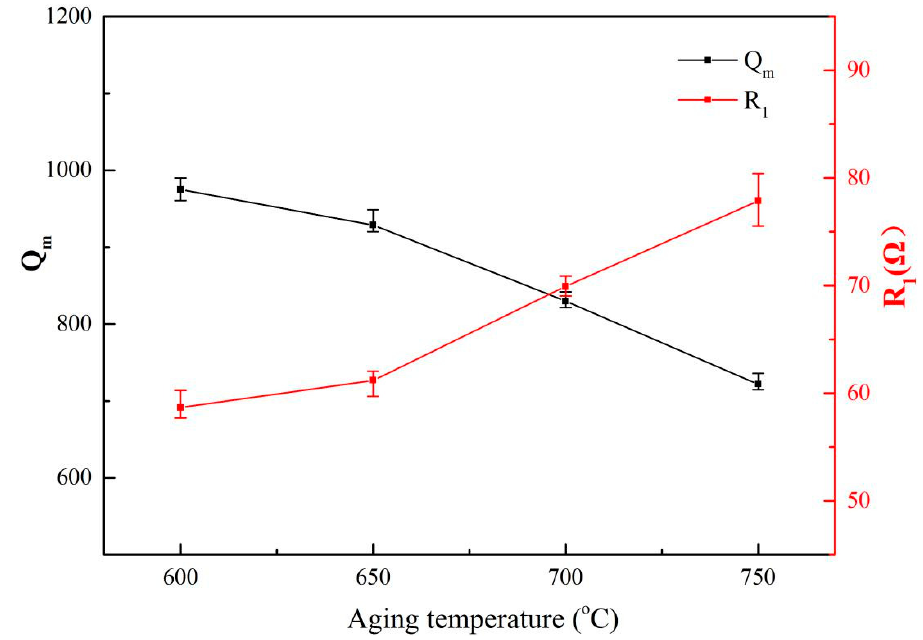
Figure 7. Ultrasonic resonant parameters of Ti6Al4V alloy vibrator under different aging temperature.